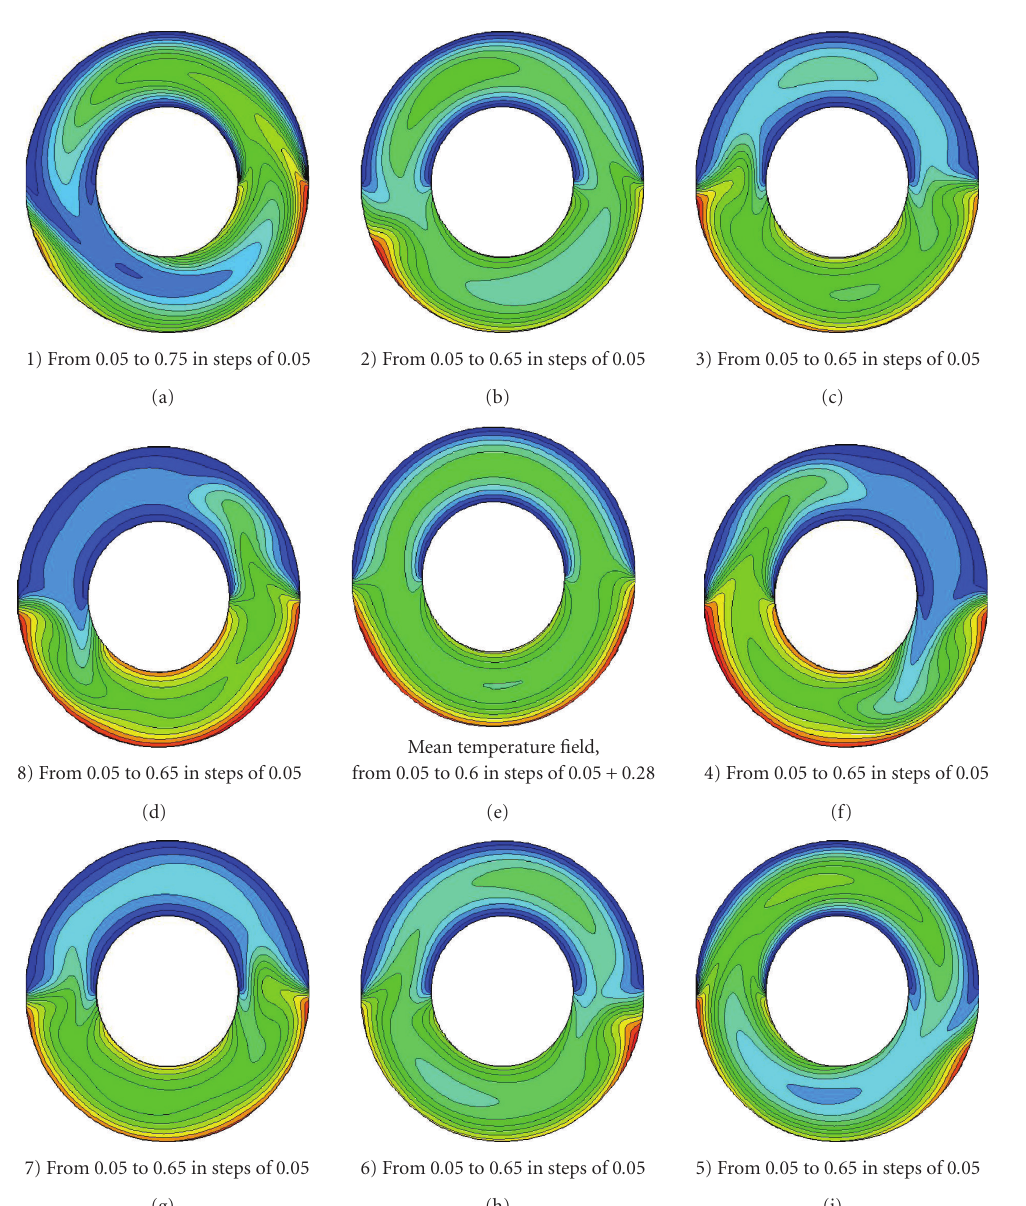
Figure 10: Equally spaced snapshots of the temperature; Ra = 15 000, R = 2 . 0, and Pr = 5.